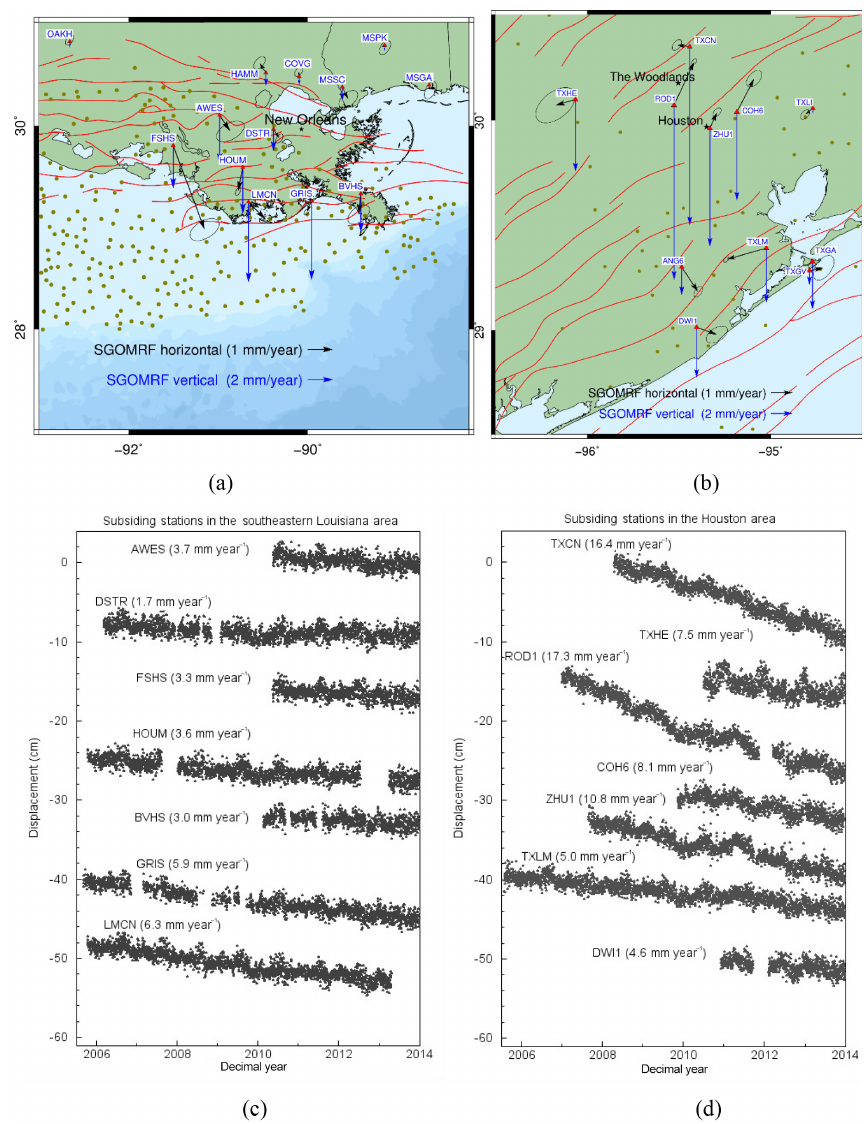
Figure 9. Top maps show vertical and horizontal velocity vectors in (a) southeastern Louisiana and (b) Houston. Bottom plots show vertical positional time series of subsiding stations in (c) southeastern Louisiana ( > 1.5mmyr − 1 ) and (d) Houston-Galveston ( > 4.5mmyr − 1 ). The reference frame is